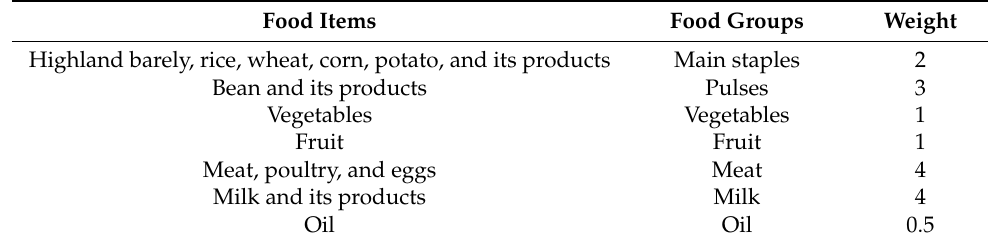
Table 1. Food groups and standard weights used in